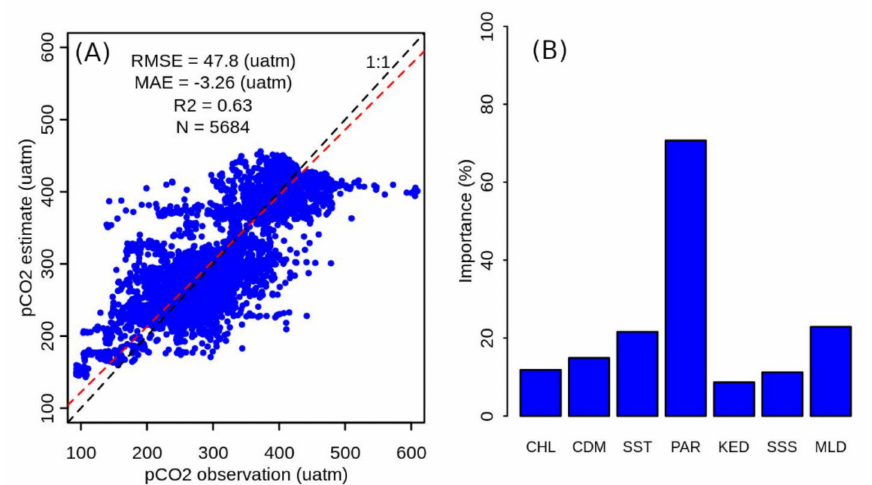
Figure 4. The final random forest model for the pCO 2 estimate. ( A ) Quality performance of the model, where the red dashed line is the regression line between the pCO 2 observation and the estimate and black dashed line is 1:1 line; ( B ) the variables’ importance in the